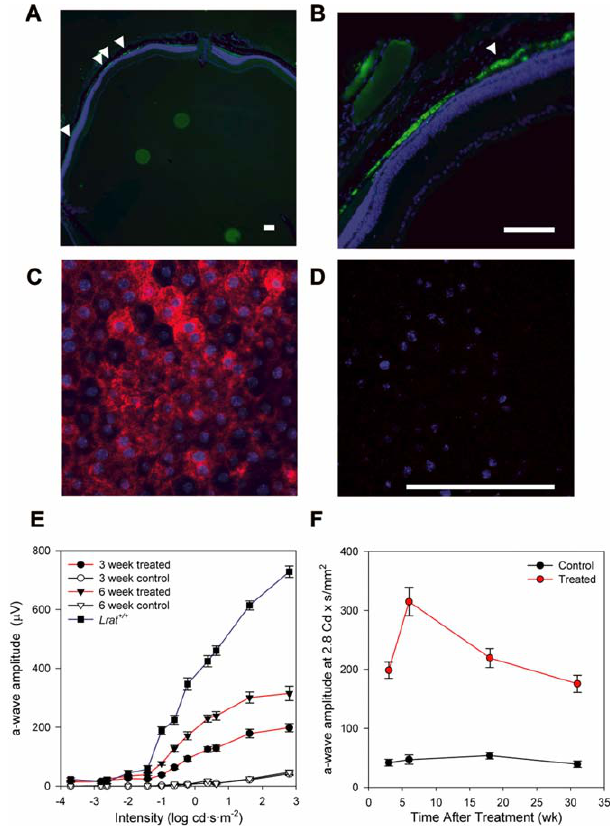
Figure 5. Immunocytochemistry and ERG of rAAV- Lrat -Treated Lrat (cid:2) / (cid:2) Mice (A) Immunolocalization of LRAT (green) in rAAV- Lrat treated Lrat (cid:2) / (cid:2) mouse eye. Anti-LRAT antibody was directly labeled by Alexa 488. Expression of LRAT is locally restricted (arrowheads) in the eye. Nuclei are stained by Hoechst 33342 (blue). (B) Higher-power magnification image of (A). LRAT (green) is observed specifically in the RPE cell layer. (C) Subcellular localization of LRAT in rAAV- Lrat treated Lrat (cid:2) / (cid:2) mouse eye. RPE cells were labeled by anti-LRAT and detected by Cy3-labeled secondary antibody (red). Nuclei are stained by Hoechst 33342 (blue). RPE cell layer was mounted flat on a coverslip and imaged. LRAT is localized in the internal membrane of the RPE cells. Similar localization was observed for WT mouse RPE cells [12]. (D) Control flat-mounted RPE cell layer of untreated Lrat (cid:2) / (cid:2) mouse. Anti- LRAT antibody does not show any non-specific labeling. Bars indicate 100 l m. (E) Comparison of scotopic single flash ERG of rAAV- Lrat treated, Lrat þ / þ , and Lrat (cid:2) / (cid:2) control mice as measured by a-wave amplitudes, ( n (cid:4) 16, data shown with SD). (F) A plot of a-wave amplitudes at 2.8 cd (cid:3) s (cid:3) m (cid:2) 2 intensity as a function of post-treatment time for rAAV- Lrat treated mice. DOI: